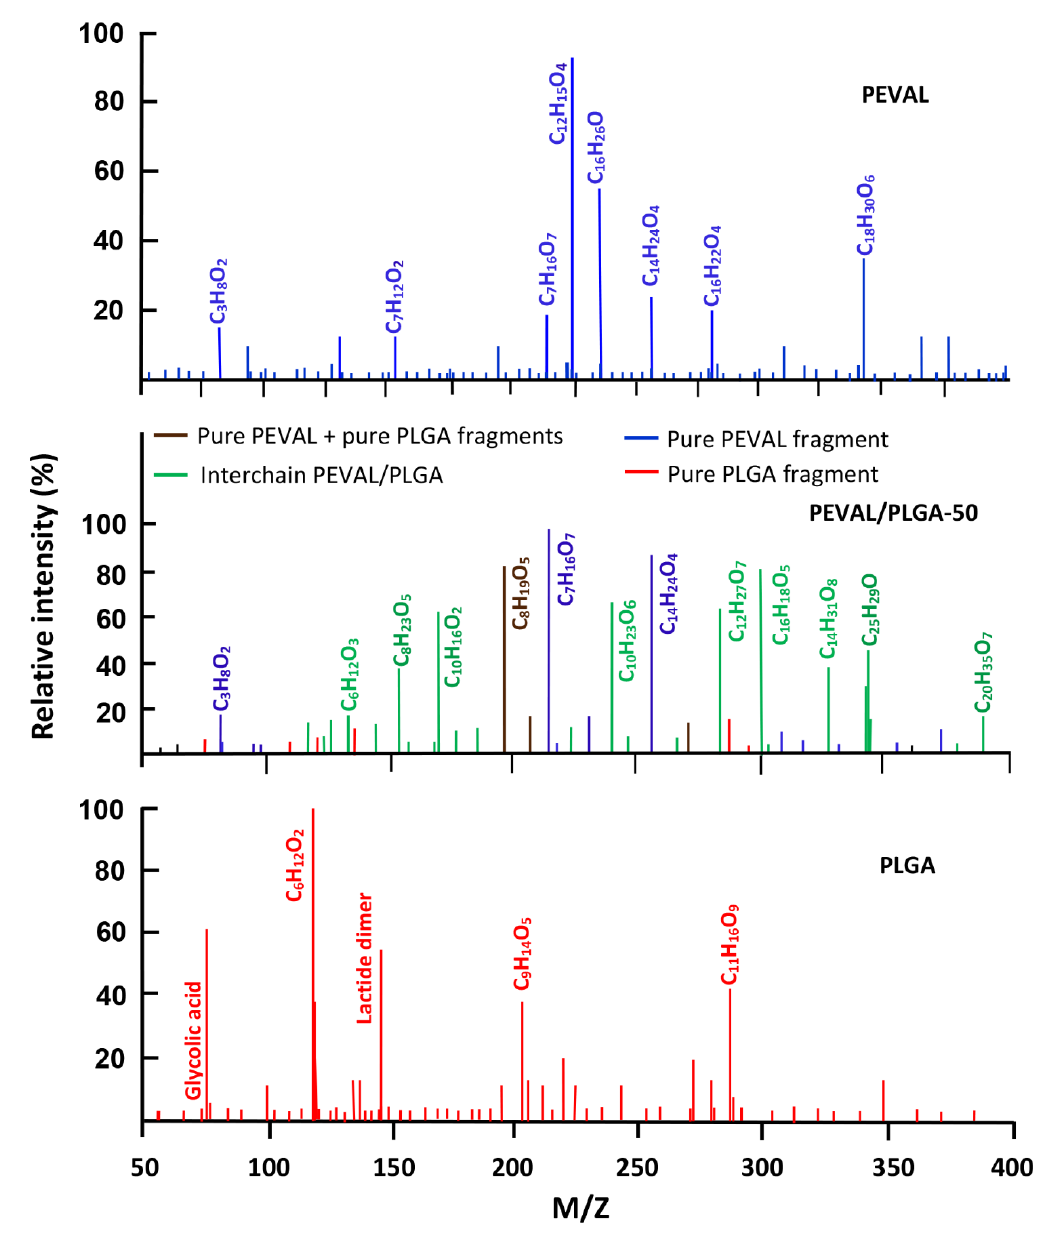
Figure 13. Comparative spectra of pure PEVAL, PLGA, and their blend with 50 wt% of each component. The results of the thermal decomposition of the PEO/PHPMC system containing 30 and 70 wt% PEO and those of their pure components obtained by the DART-Tof-MS method are presented in Figure 14. As it can be seen from the spectrum of the blend with 30 wt% PEO, new signals (in green) belonging to new fragments resulting from interchain scissions involving the two interpenetrated network polymers, in addition to those generated from intrachain scissions within the pure polymers (in brown, blue and red). This result reveals the miscible behavior of this blend in this composition. However, the blend containing 70% PEO presents practically only the signals belonging to the two pure polymers (in brown, blue and red) thus revealing the immiscible character of this blend in this composition. Such behavior was also observed by Basavaraju et al. [23] using viscosimetry, ultrasonic, refractive index, and density measurements. These authors concluded that this system remains miscible when PEO incorporated in this blend is greater than 50